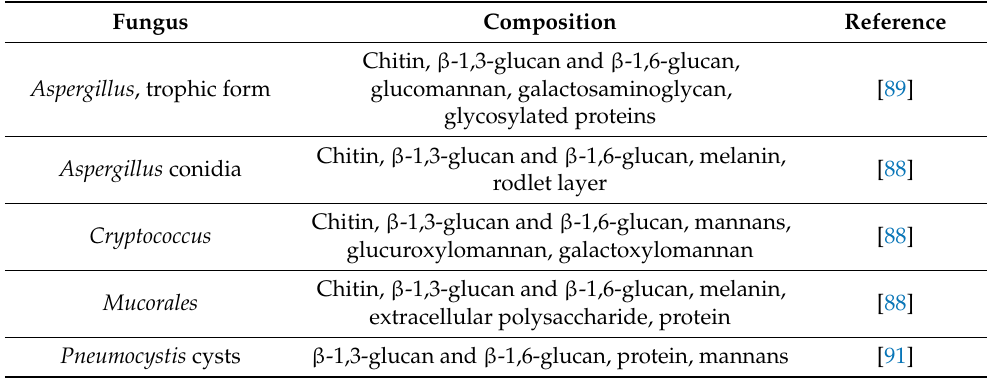
Table 1. Main compounds of the walls of opportunistic fungi listed from plasma membrane to outer